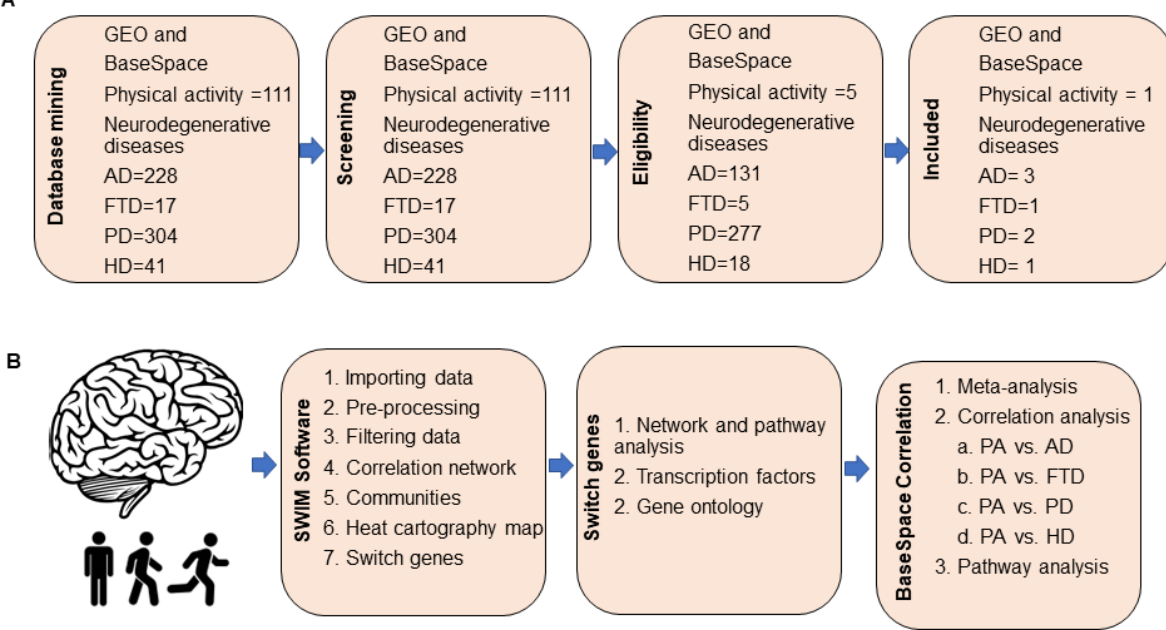
Figure 1. Overall study design. ( A ) We searched GEO and BaseSpace Correlation Engine (BSCE) databases for brain transcriptomic studies from subjects who engaged in different levels of physical